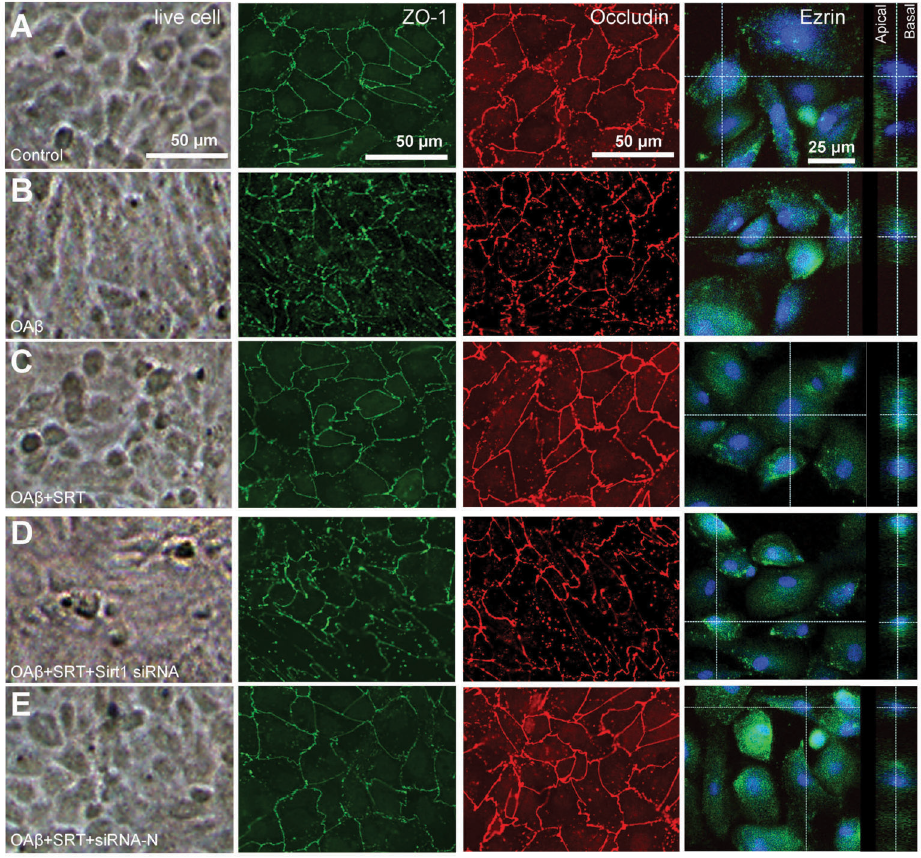
Figure 4. Effects of A b , SRT1720 and knockdown of SIRT1 on morphology and locations of occludin, ZO-1 and ezrin staining of RPE cells. RPE cells were incubated with varying stimuli for 48 h as follows: A , DMEM/F12 medium; B , 0.3 m M OA b ; C , 5 m M SRT1720 for 1 h before A b was added; D , SIRT1-silenced RPE cells were incubated with SRT1720 (5 m M) 1 h before A b was added; E , Negative siRNA-transfected RPE cells were incubated with SRT1720 (5 m M) 1 h before A b was added. Light microscopy showed that cells treated with OA b ( B ) or transfected with SIRT1 siRNA ( D ) displayed irregular morphology compared with control ( A ), but pretreatment with SRT1720 ( C , E ) reversed the effects induced by A b . Immunostaining of occludin and ZO-1 showed that the localization of occludin and ZO-1 perfectly matched the typical cobblestone-like morphology of RPE in the control ( A ) or SRT1720-pretreated cells ( C ), whereas it showed not only disorganization of the occludin and ZO-1, but also disappearance of typical cobblestone-like morphology in OA b -treated ( B ) or SIRT1-silenced cells ( D ). ZO-1: green; occludin: red; ezrin: green; DAPI: blue; apical: apical side of RPE monolayer; basal: basal side of RPE